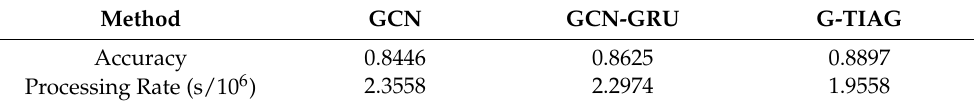
Table 8. Results of ablation